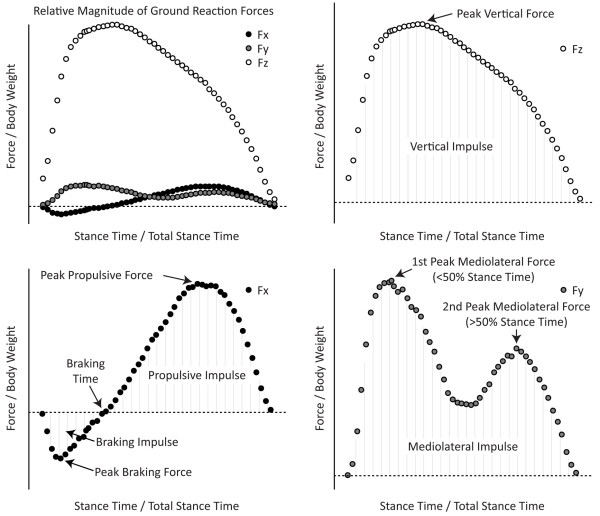
Generalized measurement to describe the ground reaction force curves of a walking rat. Ground reaction forces were reduced into generalized measurements, as described by Howard and co-workers [24]. The relative size of the ground reaction forces are described in the top left panel. Vertical (Fz) forces are the largest ground reaction forces; here, a loading, support, and unloading phase can be observed (open circles, top right). Vertical ground reaction forces were generalized into peak vertical force (the largest vertical force achieved) and vertical impulse (the area under the Fz-time curve). Braking-propulsion forces (Fx) resemble a negative sine wave (solid circle, bottom left). Braking forces (-Fx) slow the linear translation of the center of mass in the direction of travel. These forces are observed early within the Fx-time curve and can be generalized into peak braking force and braking impulse. Propulsive forces (+Fx) propel the center of mass along the direction of travel. These forces occur later in Fx-time curve and can be generalized into peak propulsive force and propulsive impulse. Finally, mediolateral forces are directed at the midline of the animal and tend to have two distinct peaks (shaded circles, bottom right). The first peak (at < 50% stance time) represents the slowing of the center of mass as it is being transferred from the contralateral limb to the ipsilateral limb; or in other words, the center of mass is being translated onto the ipsilateral limb such that the contralateral limb may enter its swing phase. This region is generalized as the first peak mediolateral force. The second peak (at > 50% stance time) represents the force that must be generated to propel the center of mass to the contralateral limb such that the ipsilateral limb may enter its swing phase. This region is generalized as the second peak mediolateral force. The mediolateral force curve can also be generalized by the mediolateral impulse.